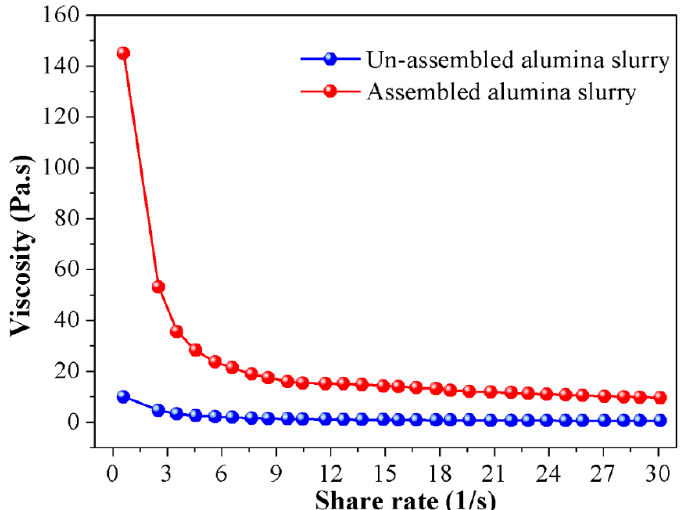
Figure 3. The relationship between viscosity and shear rate for the alumina slurries before and after assembling.